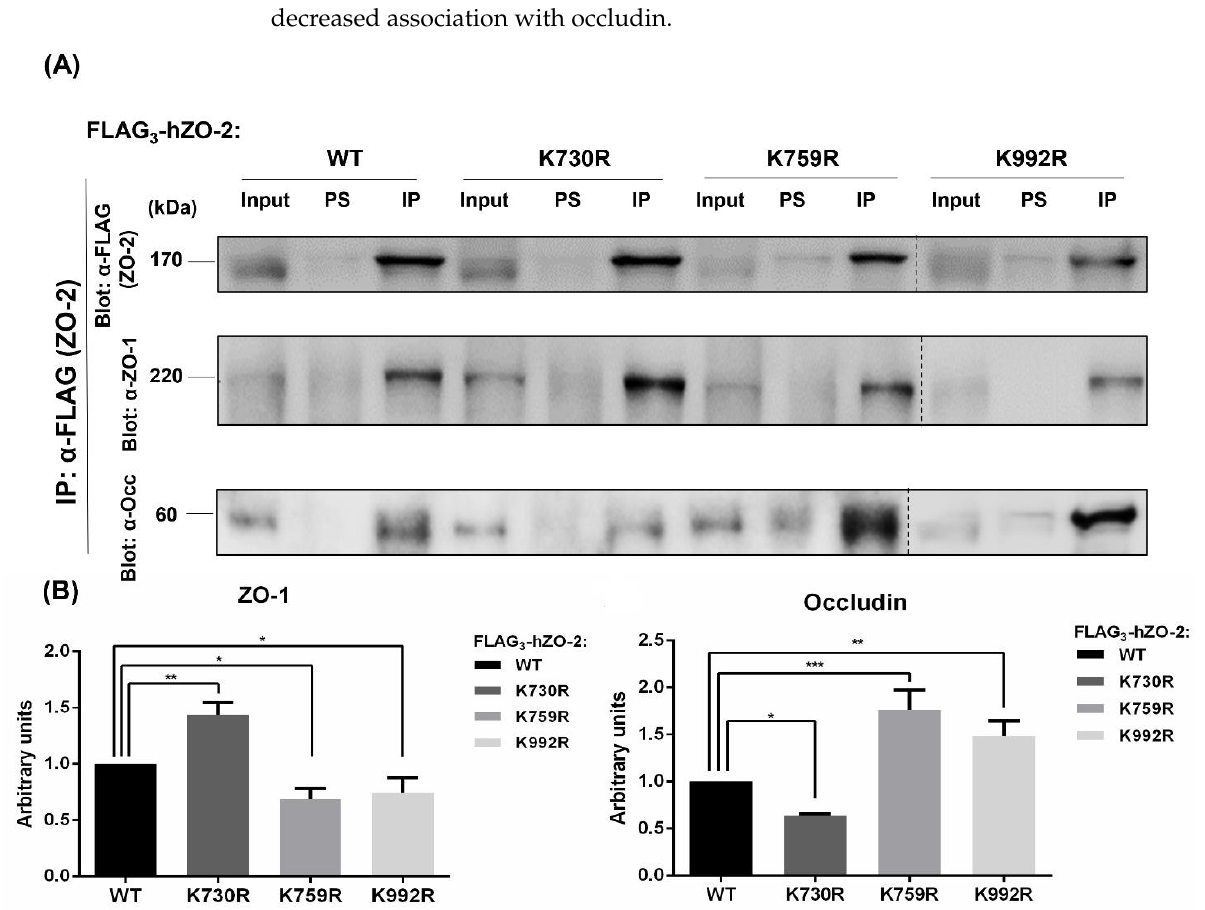
Figure 6. The mutation of K759 or K992 ubiquitination sites, or K730 SUMOylation site in hZO-2 alters the interaction with occludin and ZO-1. MDCK monolayers were transfected with Flag 3 -hZO-2 WT or the mutants FLAG 3 -hZO-2 -K759R, - K992R, and -K730R. Transfected hZO-2 was immunoprecipitated with antibodies against FLAG, and the interacting ZO- 1 and occludin were detected with specific antibodies directed against these proteins. ( A ) Representative images of West- ern blots. ( B ) Quantitative analysis of Western blots derived from three independent experiments. Statistical analysis was done with a One- way ANOVA followed by Bonferroni’s test. * p < 0.05, ** p < 0.01, *** p <